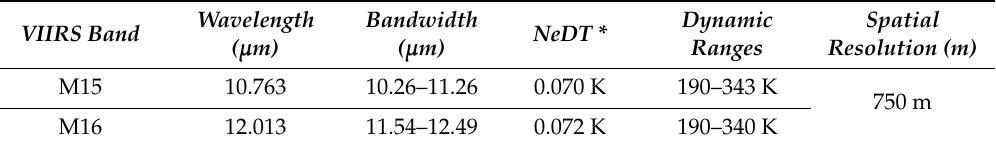
* NeDT represents noise equivalent di ff erential temperature.